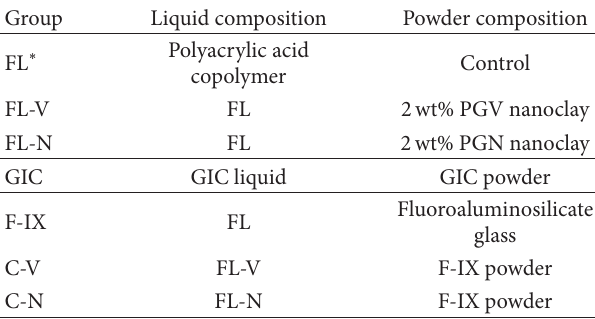
Table 1: Compositions and abbreviations of different experimental groups.